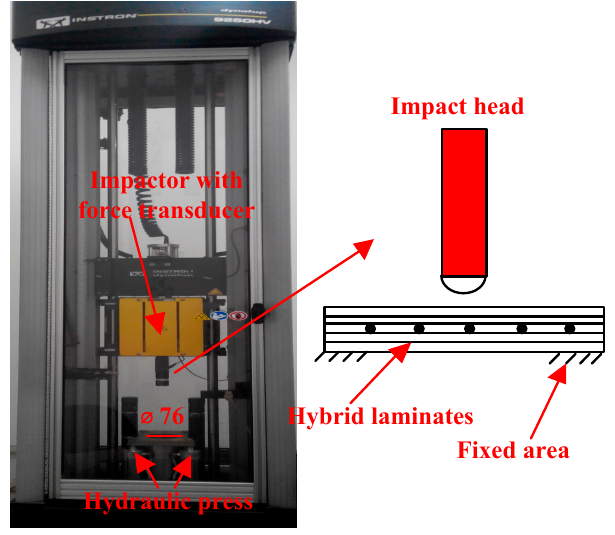
Figure 3. Instron Dynatup 9250HV drop weight impact testing machine.